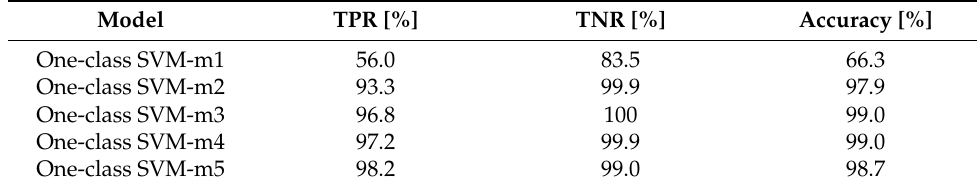
Figure 16. Accuracy according to the training progress (CNN-m2). Table 11. Test results of the CNN-based anomaly detection models.